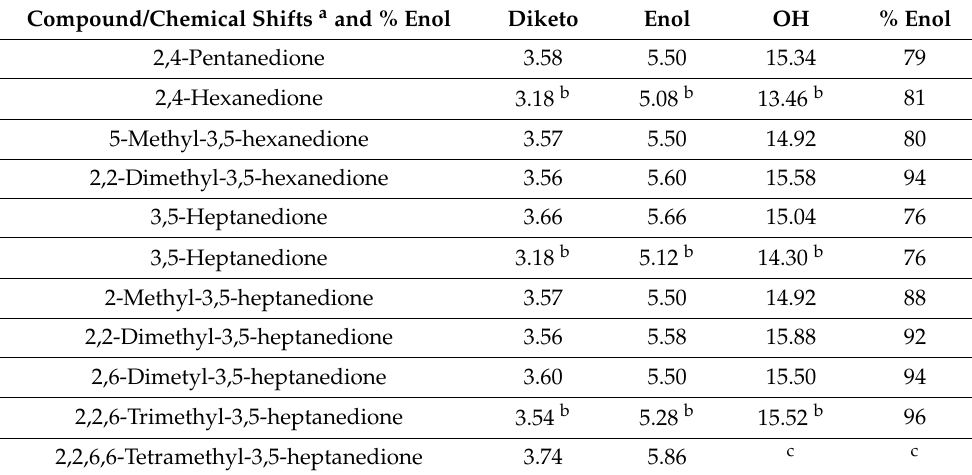
Table 1. 1 H chemical shifts of CH 2 , CH, and OH protons and enol percentage. From [24] with permission from the American Chemical